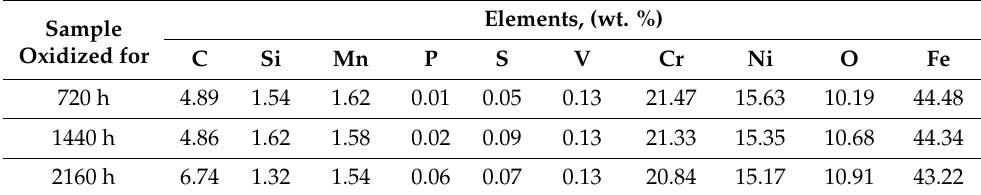
Table 3. Elemental concentration (wt. %) from EDS results of 310H oxidized samples for different periods in supercritical static water at 550 ◦